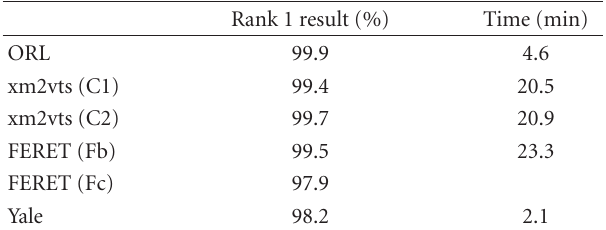
Table 1: The results of 4-component size 30 × 30 for the new